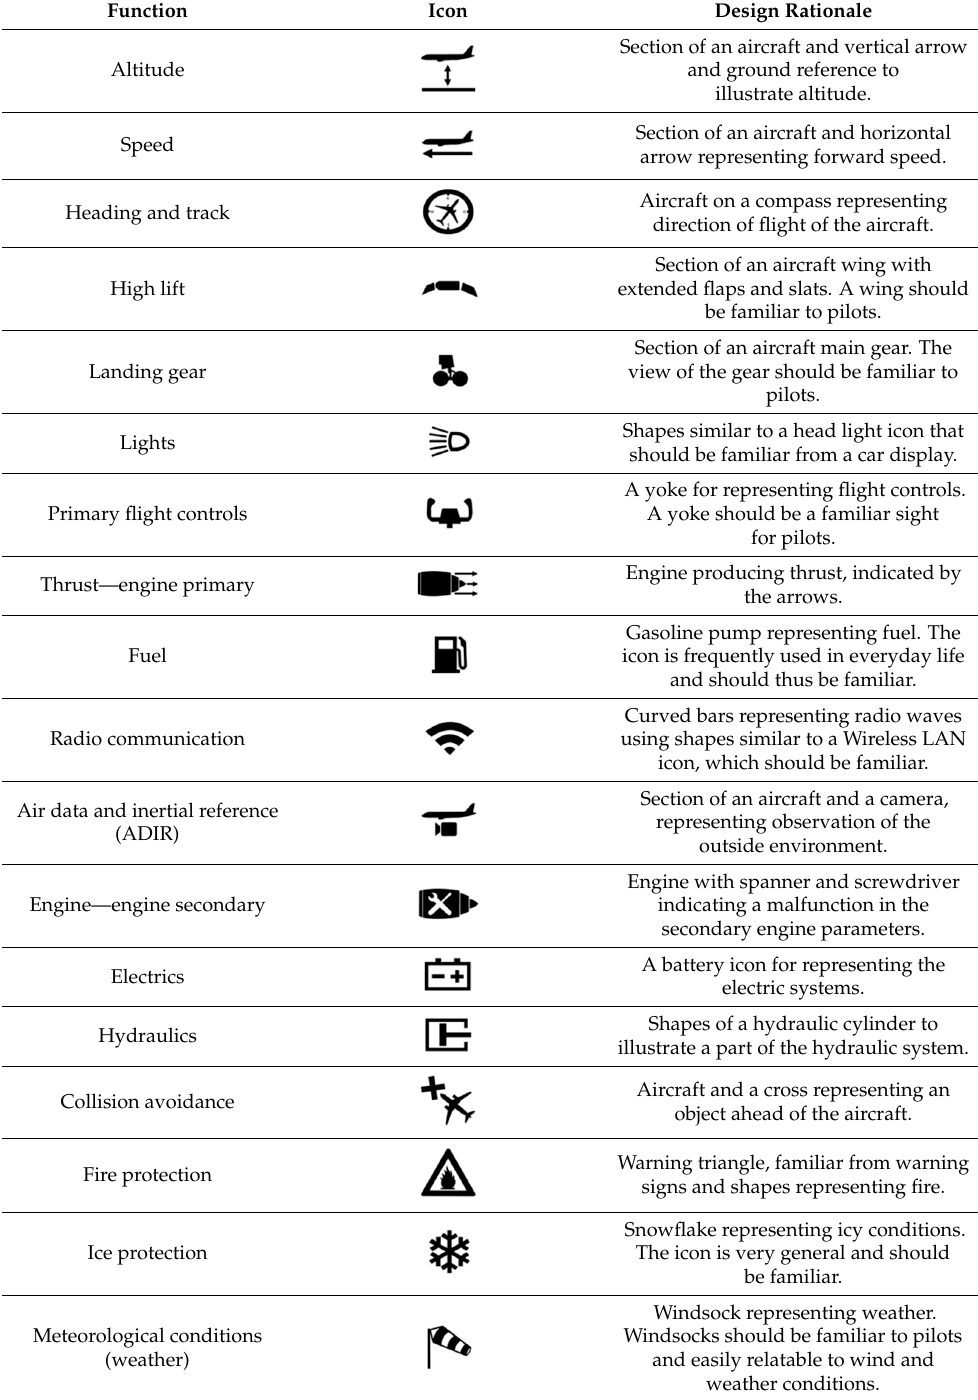
Table 2. Designed icons and descriptions of the design